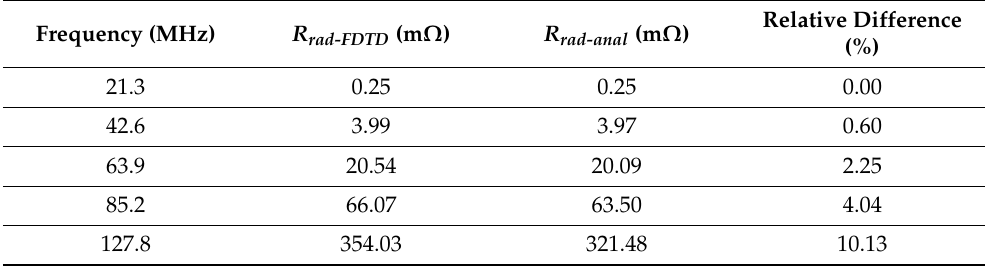
Table 7. Coil radiation resistance estimation for different frequencies ( n = 2-segment loop): FDTD and analytical calculation